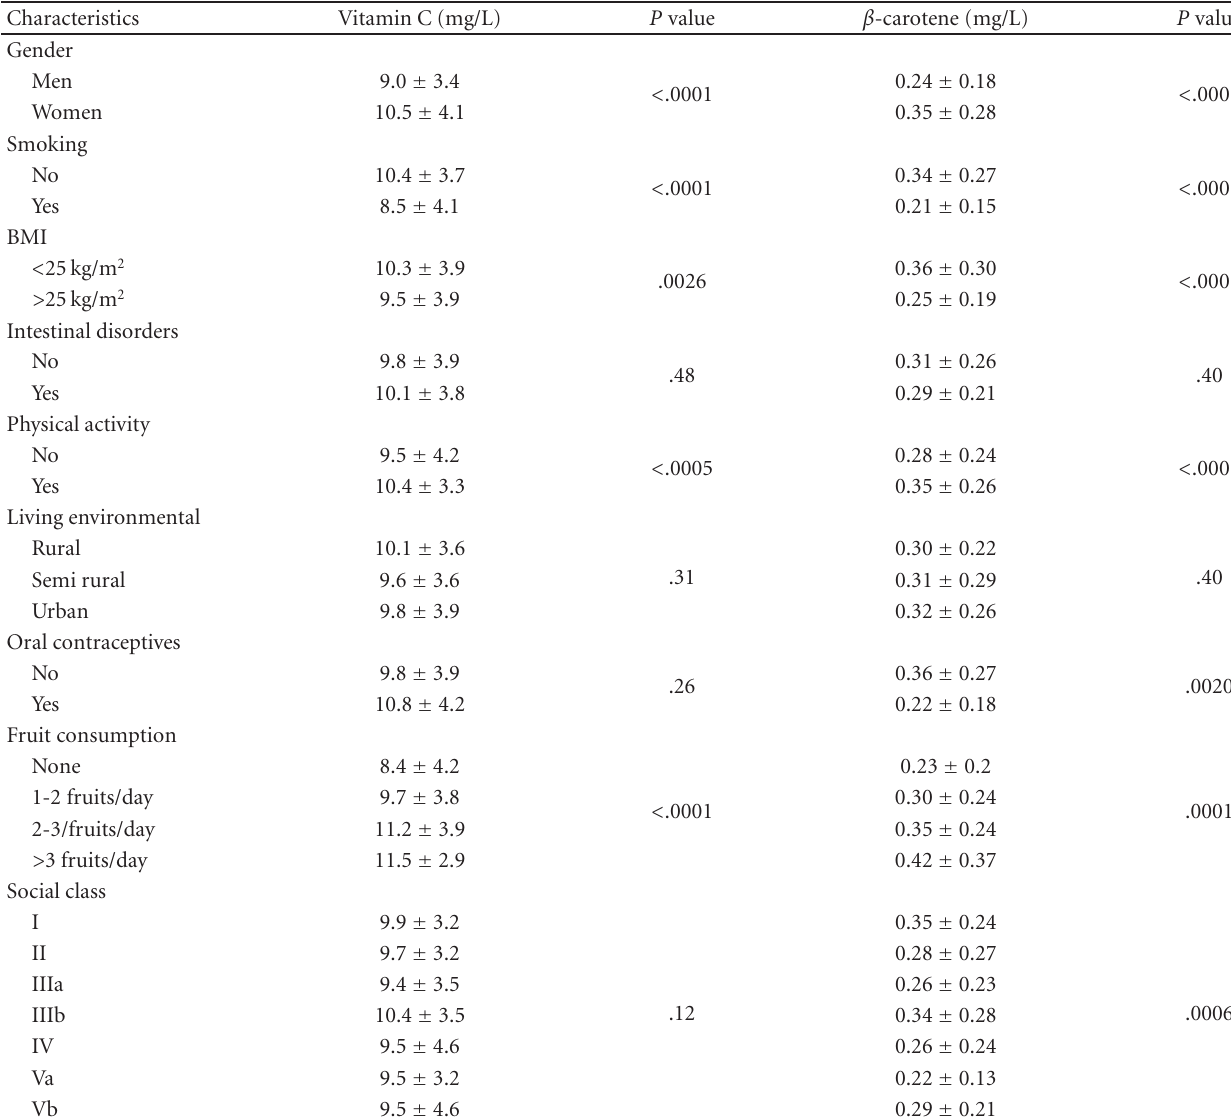
Table 2: Vitamin C and β -carotene plasma concentrations according to subject’s characteristics. Data are expressed as mean ± SD.